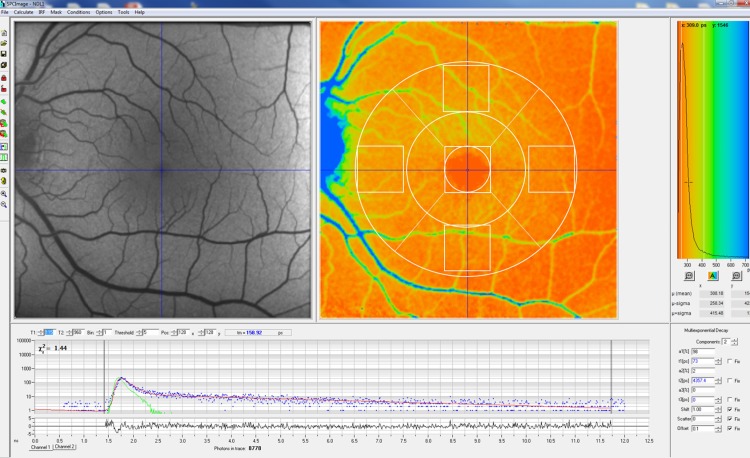
Example of a standard blue-light autofluorescence image (left) and fluorescence lifetime image of a normal subject with an overlaid ETDRS grid (right).